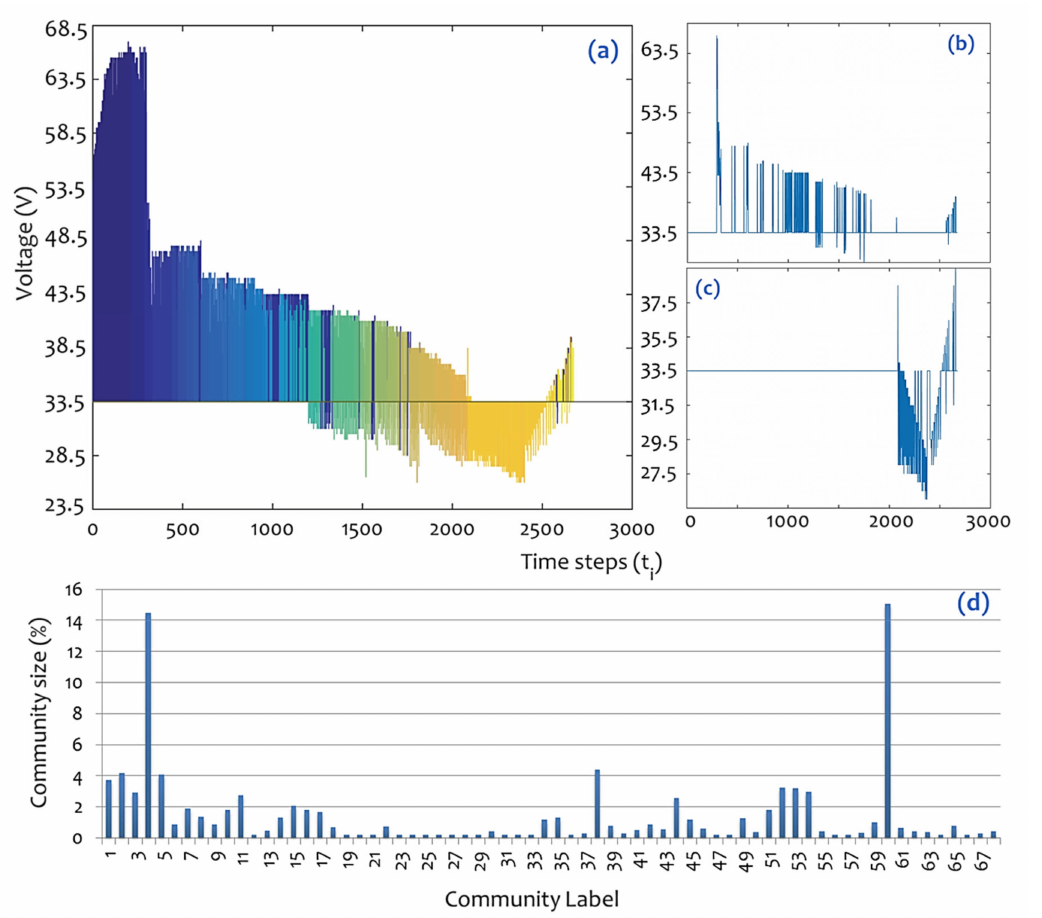
Figure 6. Results of the community detection analysis based on the modularity optimization algorithm of Blondel et al. (2008), where ( a ) is a heat-plot of the community number corresponding to each node in the source (TlInTe 2 ) time-series, ( b ) shows the first major community ( Q 4 ) containing 14.52% of the total time-series nodes, ( c ) shows the second major community ( Q 60 ) containing 15.08% of the total time-series nodes, and ( d ) is a frequency bar-chart showing the size of each community (% of the total time-series